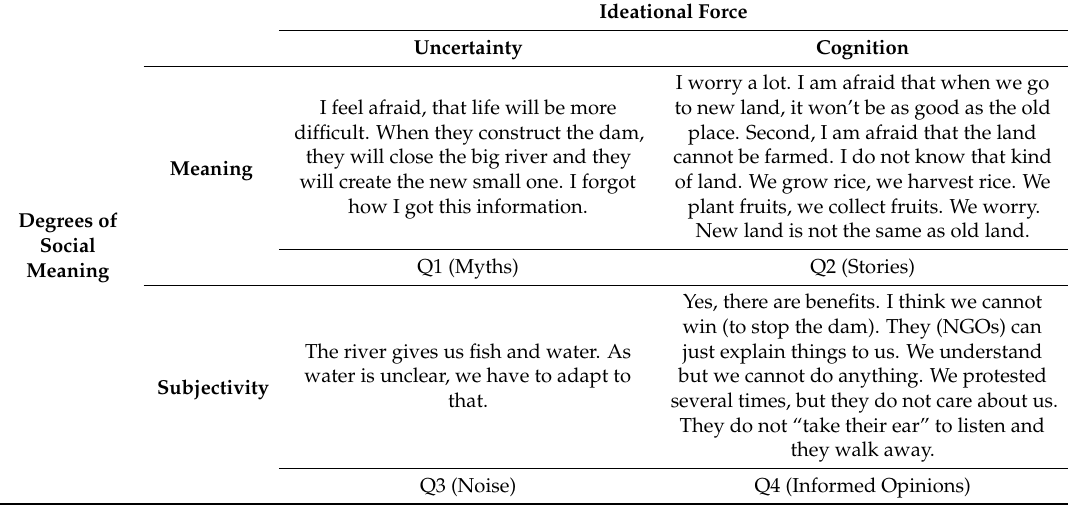
Table 1. The matrix of social construction of international political economy (IPE). Based on Abdelal et al. [14].